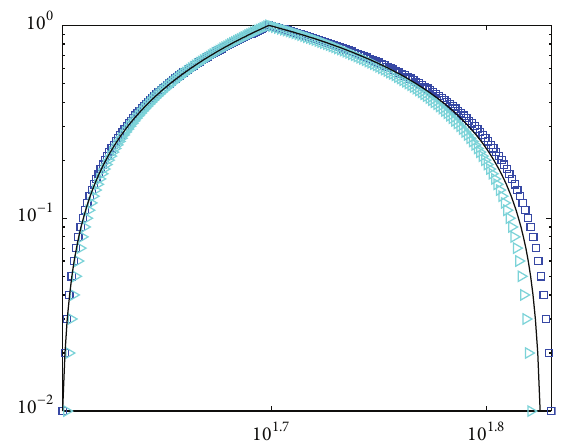
̃𝑏 (−) and the value of the first row for ̃𝑥 −,𝑙,𝑢 1